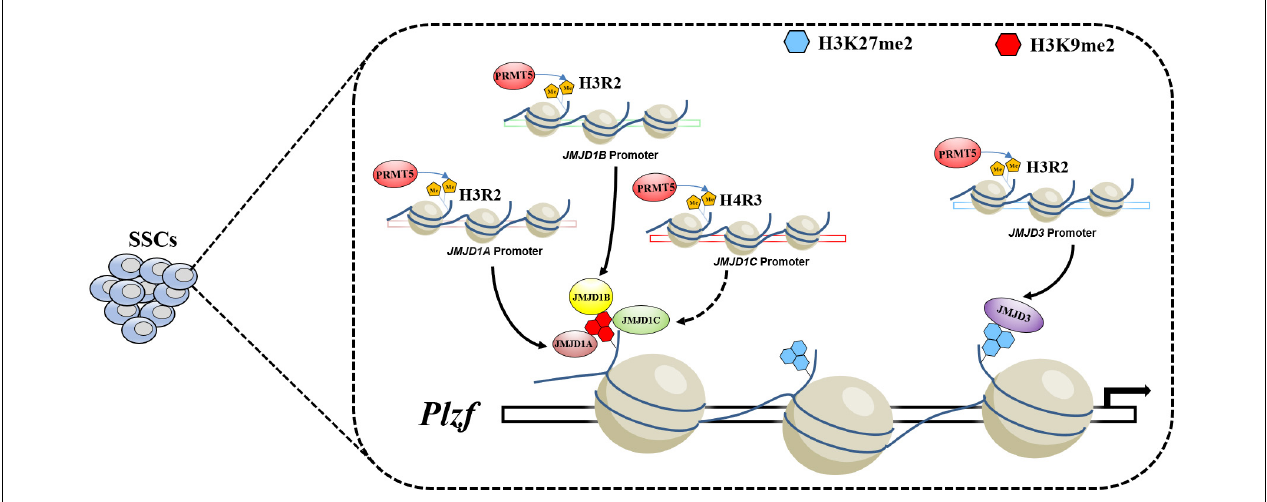
FIGURE 8 | Model of PRMT5 regulating Plzf expression via histone modifications in SSCs. In SSCs, PRMT5 promotes the expression of demethylases for H3K9me2 and H3K27me2 by catalyzing permissive histone H3R2me2s. The high expression of the corresponding lysine demethylases leads to low levels of H3K9me2 and H3K27me2 at the upstream promoter of Plzf , which in turn leads to the upregulation of the Plzf gene.